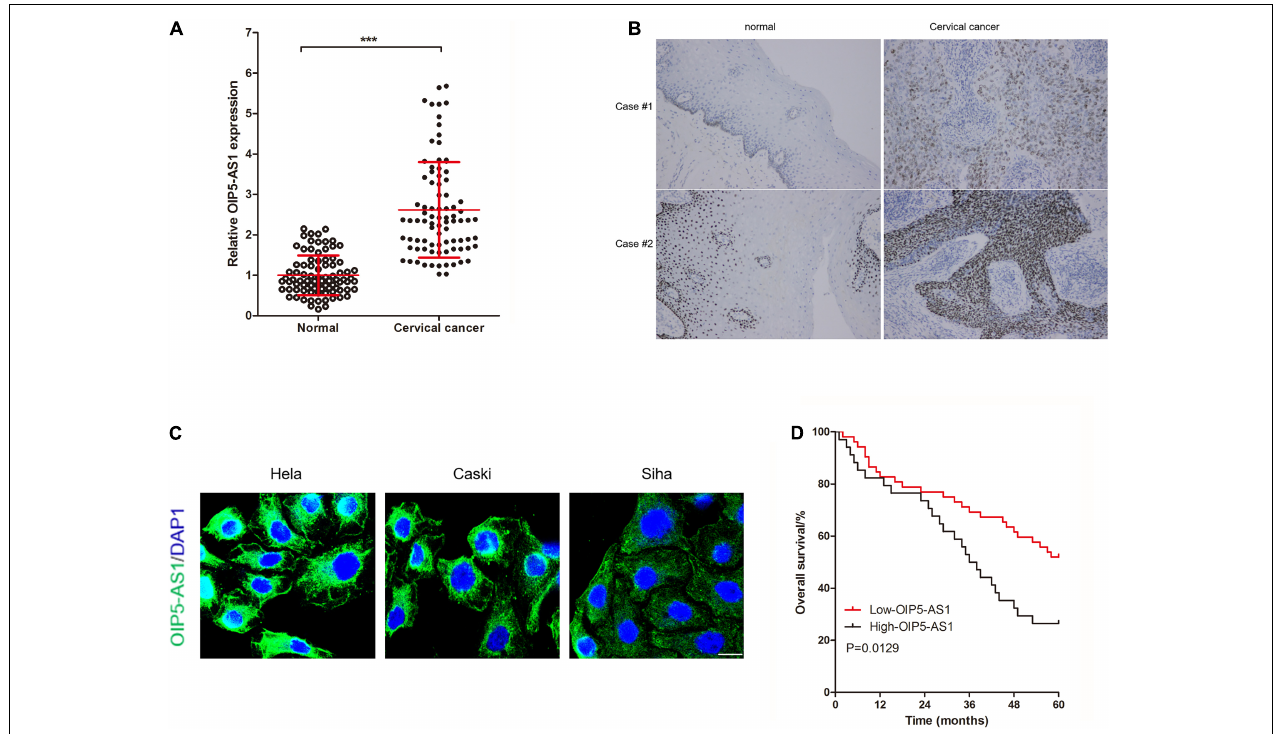
FIGURE 1 | OIP5-AS1 is up-regulated in cervical cancer tissues and related to poor prognosis in patients with cervical cancer. (A) RT-qPCR analysis of the indicated OIP5-AS1 levels in 86 pairs of cervical cancer tissues and matched adjacent normal cervical tissues. Data are shown as (mean ± SD), *** was P < 0.001 and was calculated by paired t test. (B,C) OIP5-AS1 expression in tissues (B) and Hela, Caski, and Siha cells (C) were analyzed by FISH staining. (D) High expression of OIP5-AS1 shows poor prognosis in patients with cervical cancer. P value was calculated by Log-rank (Mantel-Cox) test.